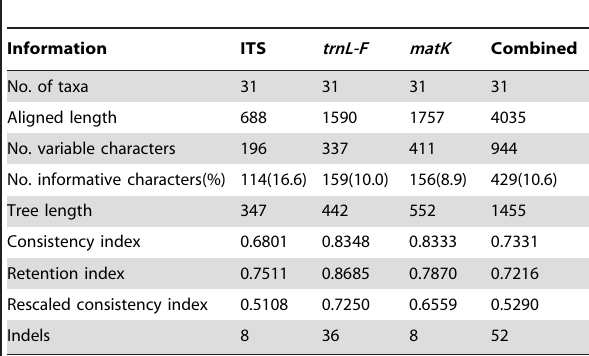
Table 1. Statistics from the analyses of the various datasets.